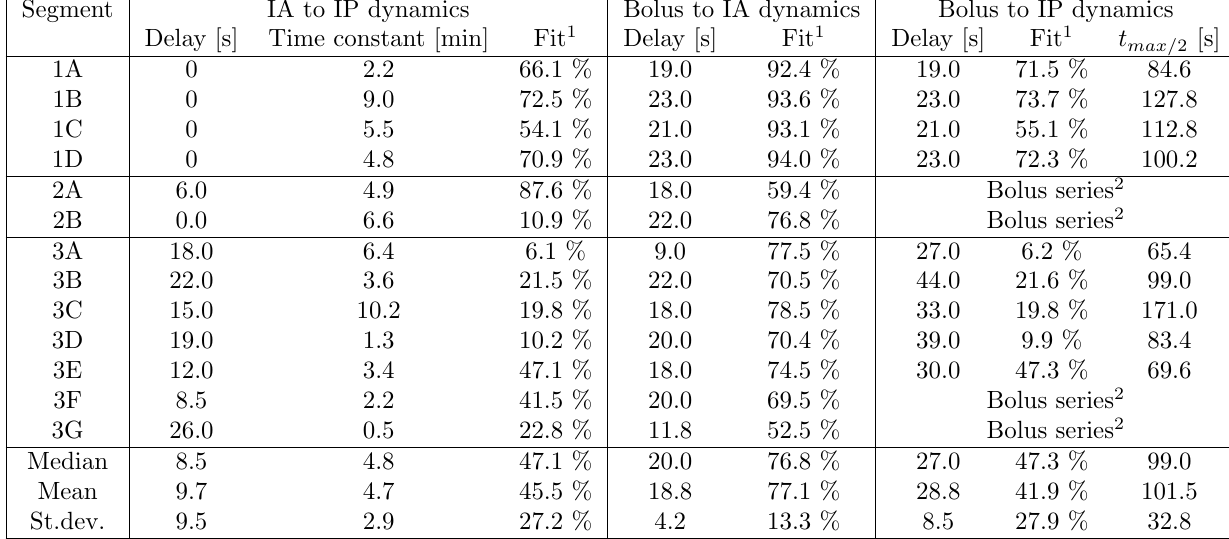
Table 1: Results summarized. The bottom part shows the median value, mean value and standard deviation for the identified